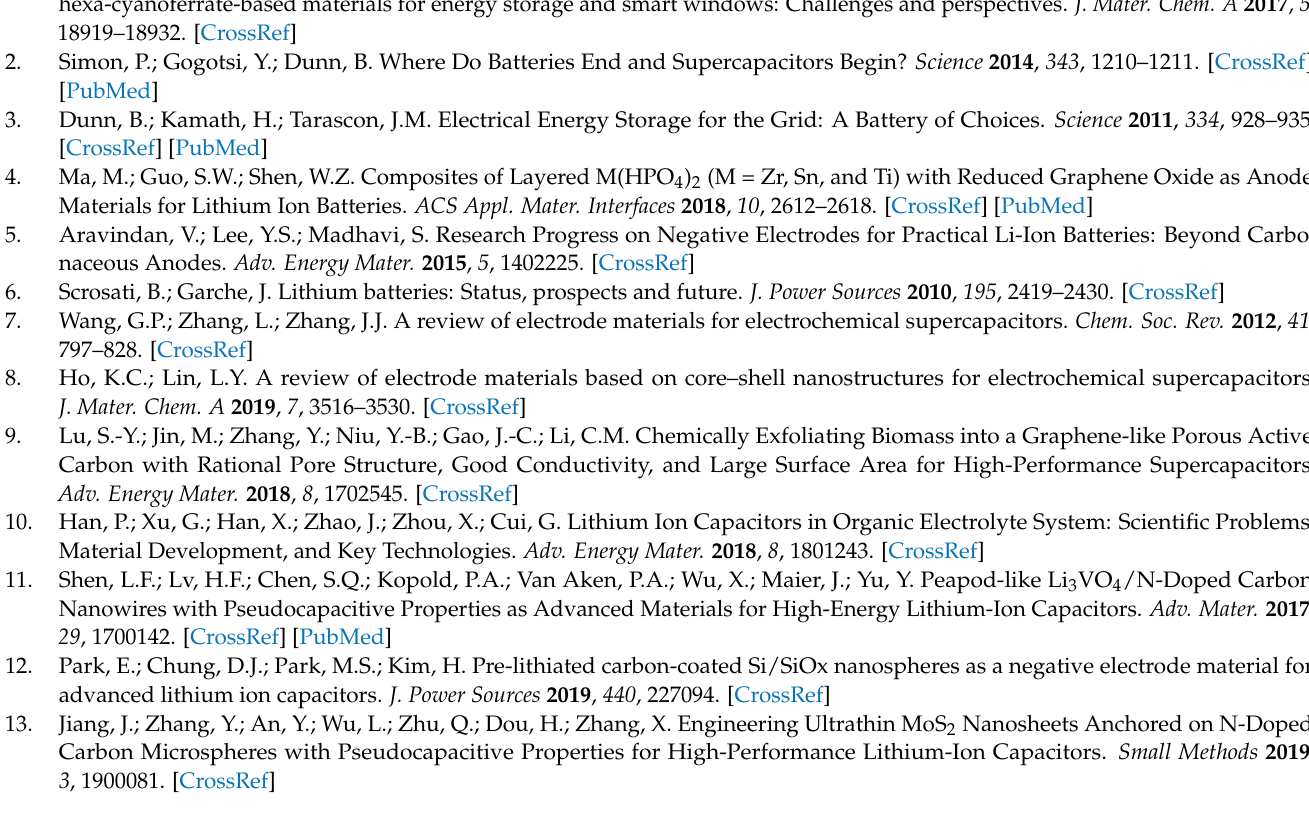
944/14/1/122/s1, Figure S1: SEM images of the (a) 20-NaVO/C and (b) 30-NaVO/C hybrids; Figure S2: Corresponding elemental distribution mapping of NaVO nanobelts. TEM image of (a) NaVO; (b) Na; (c) V; (d) O.; Figure S3: (a) N2 adsorption/desorption isotherms of YP50D; (b) pore- size distribution curves of YP50D calculated based on density functional theory method; Figure S4: CV curves at different scan rates from 1.5 V to 4 V. (a) YP50D; (b) the 20-NaVO/C hybrid; (c) the 30-NaVO/C hybrid; Figure S5: Capacitive contribution area in the CV curve at the scan rate of 1 mV s − 1 . (a) 10-NaVO/C; (b) YP50D; Figure S6: Electrochemical performance of artificial graphite (0.01–3 V) (a) rate performance at different current densities from 0.1 to 10 A g − 1 ; (b) GCD curve for the first cycle at 0.1 A g − 1 ; Figure S7: (a) CV curves of YP50D//AG (1.5:1) at different scan rates; (b) GCD profiles of YP50D//AG (1.5:1) at different current densities; Figure S8: (a) Cycling performance of 10-NaVO/C//AG (2:1) at 1 A g − 1 ; (b) Ragone plots of 10-NaVO/C//AG with different cathode-to-anode mass